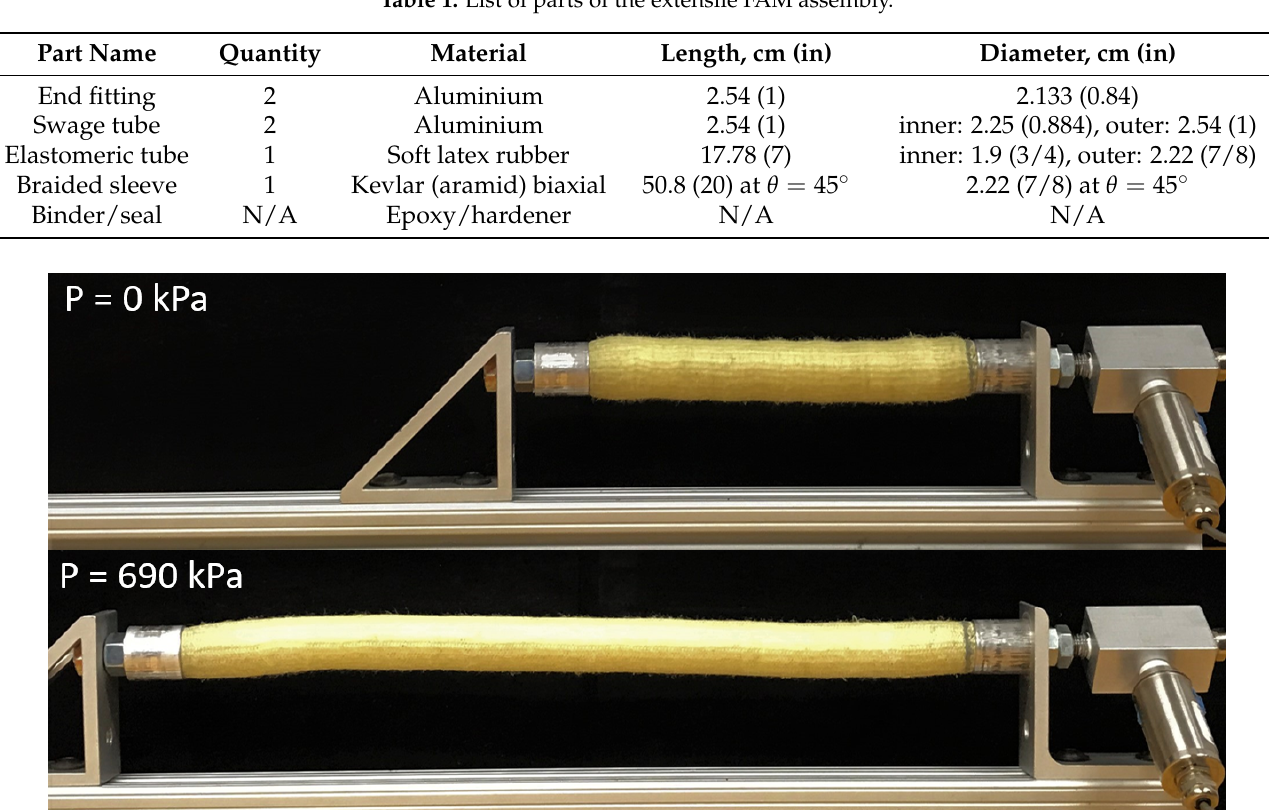
Table 1. List of parts of the extensile FAM assembly.